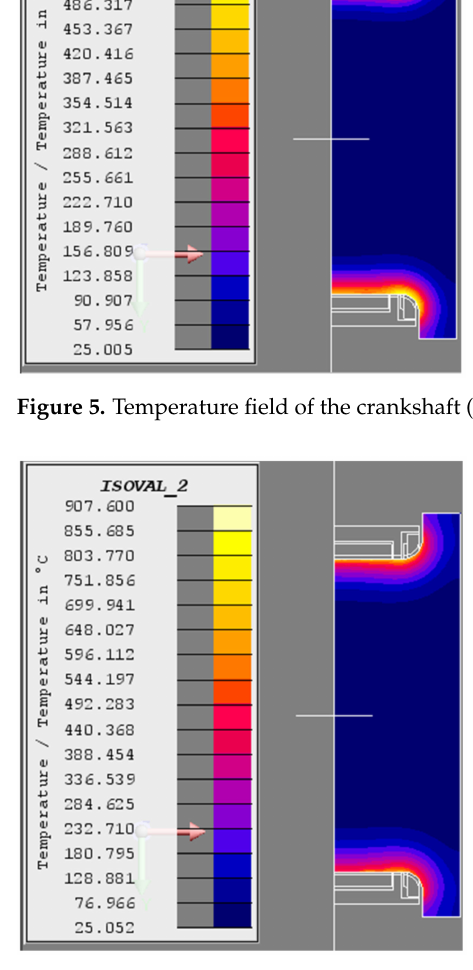
Figure 6. Temperature field of the crankshaft (T = 9